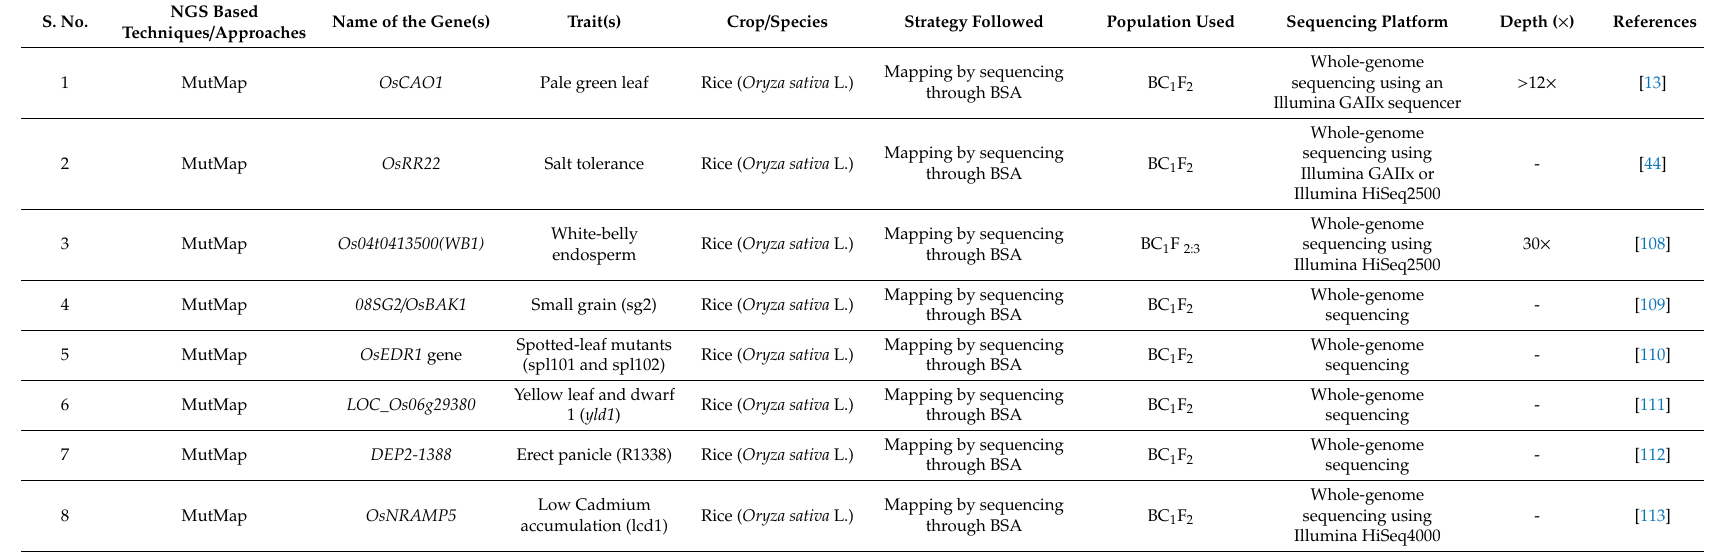
Table 3. Application of next-generation sequencing (NGS) based forward genetic approaches for identification and mapping of mutated gene in various crops. S.